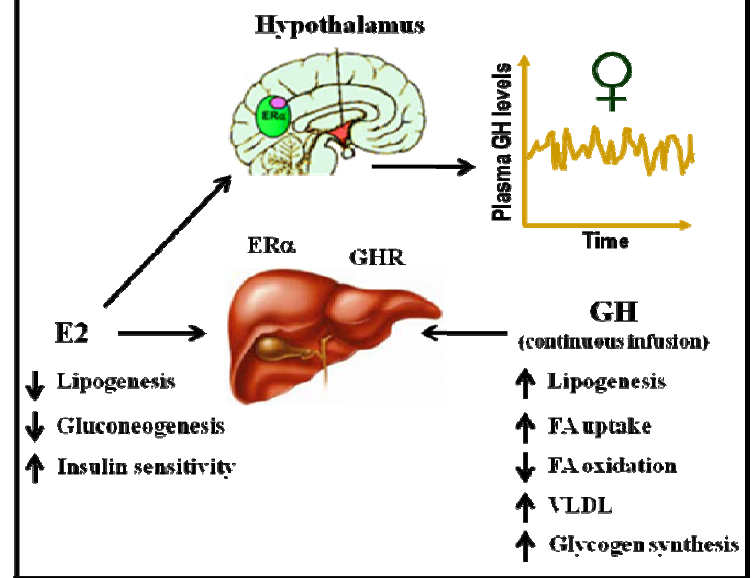
Figure 4. Physiological control of hepatic lipid metabolism by E2 and